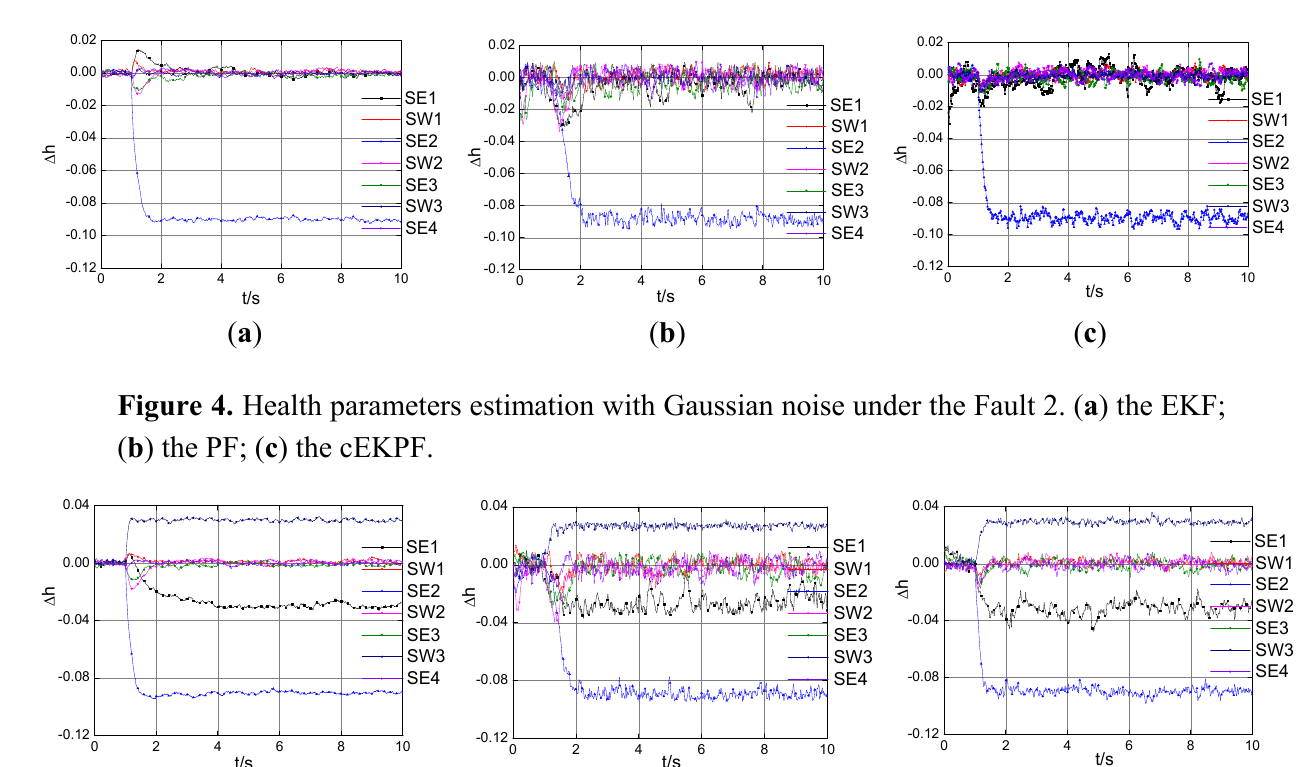
Figure 3. Health parameters estimation with Gaussian noise under the Fault 1. ( a ) The EKF; ( b ) the PF; ( c ) the cEKPF.